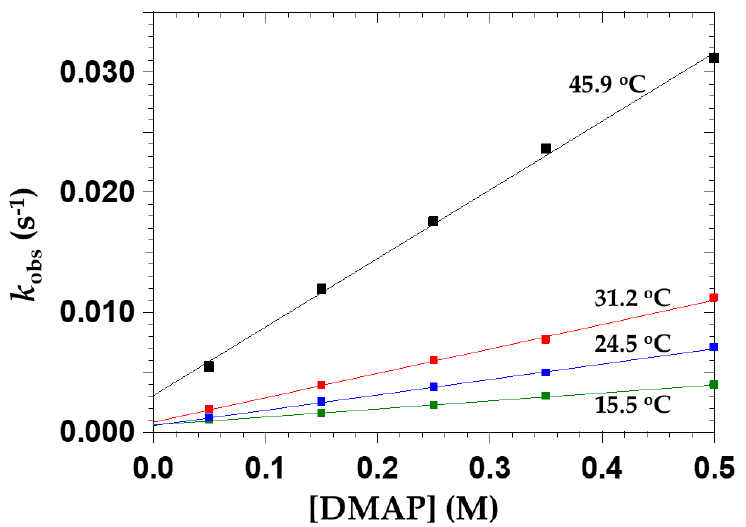
Figure 8. Plot of k obs versus [DMAP] for the substitution of triphenylphosphine oxide from cis - [NbO(ca) 2 (H 2 O)OPPh 3 ] − by DMAP in acetonitrile at four different temperatures, [Nb] = 0.001 M, λ max = 430 nm. Table 6. Summary of the kinetic data for the substitution of triphenylphosphine oxide from cis -